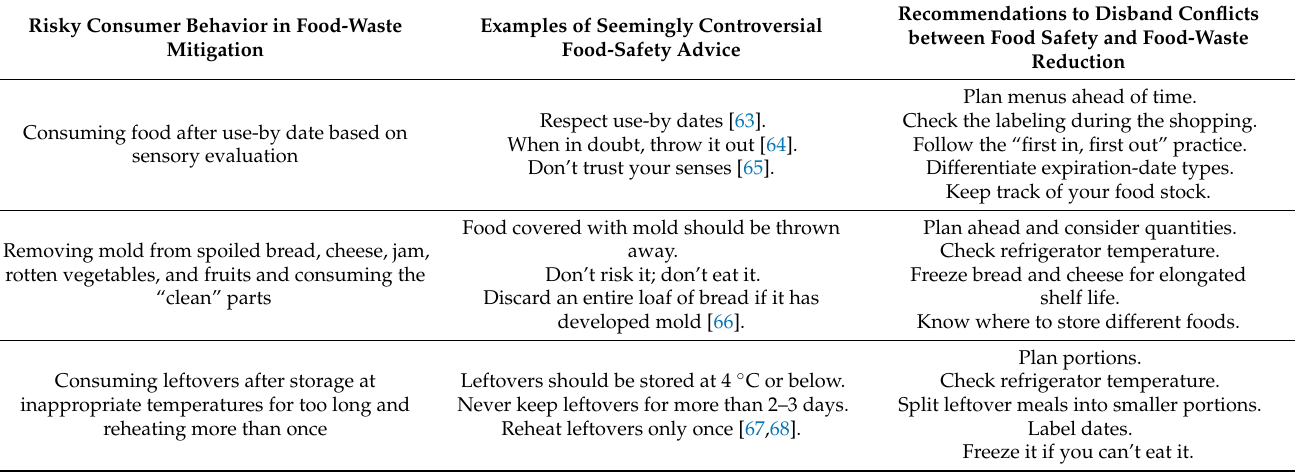
Table 1. Messages targeting risky behaviors * from the domain of sustainability–safety controversy regarding food